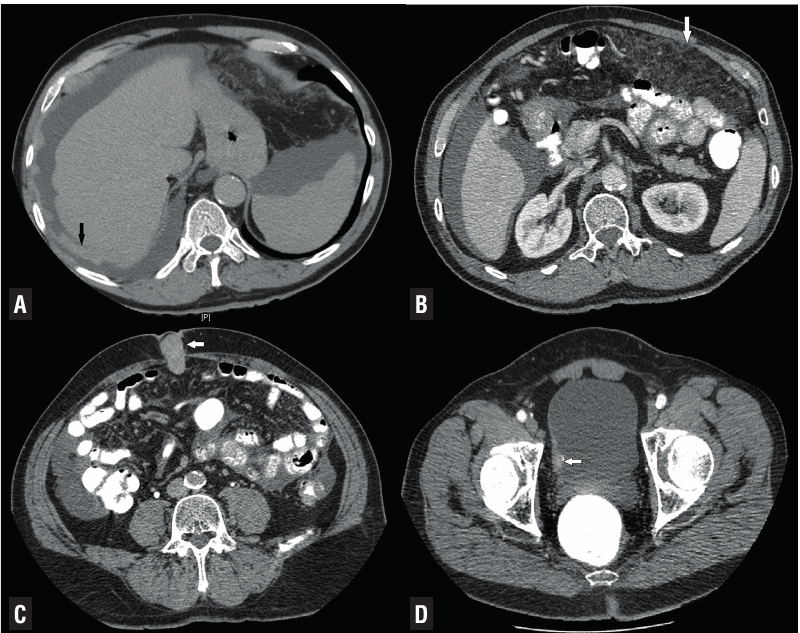
Figure 1 - A) Peritoneal thickening on the right hemidiaphragm (black arrow). B) Diffuse omental invasion of peritoneal mesothelioma (omental caking, white arrow). C) CT imaging of umbilical mass (white arrow) D) Bladder mass with sessile growth pattern (white